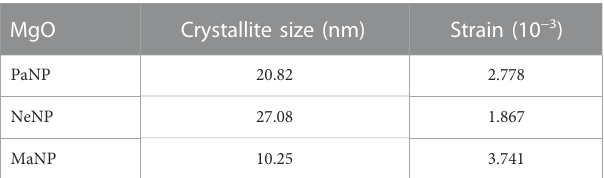
TABLE 1 Crystallite size and strain values estimated for MgO nanoparticles.